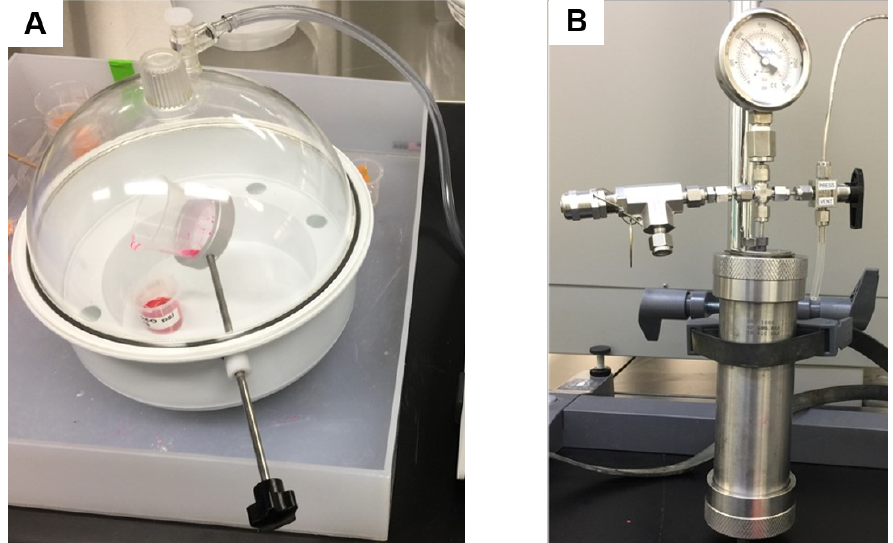
Figure 4. The equipment used for resin impregnation. ( A ) The desiccator with a tilting handle used for degassing the sample and epoxy separately when connected to a vacuum source. ( B ) High pressure vessel connected to high pressure gas